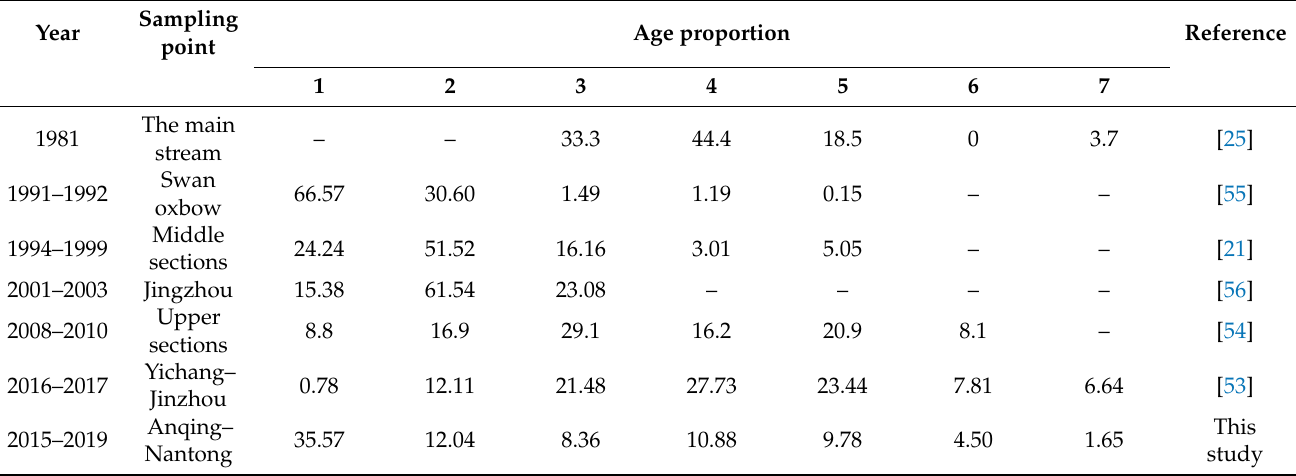
Table 6. Age structure of different Silver Carp populations in the Yangtze